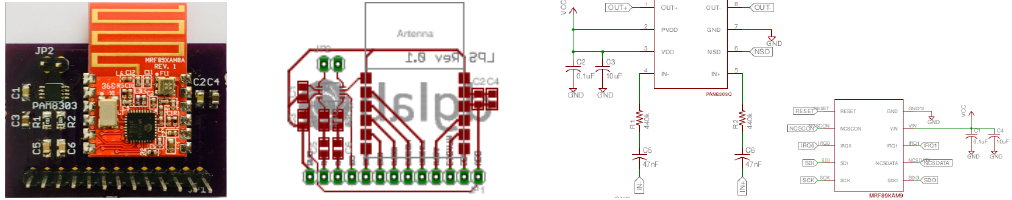
Figure 4. PCB views of the ALPS beacon including the MRF89XAM8A RF 868-MHz transceiver